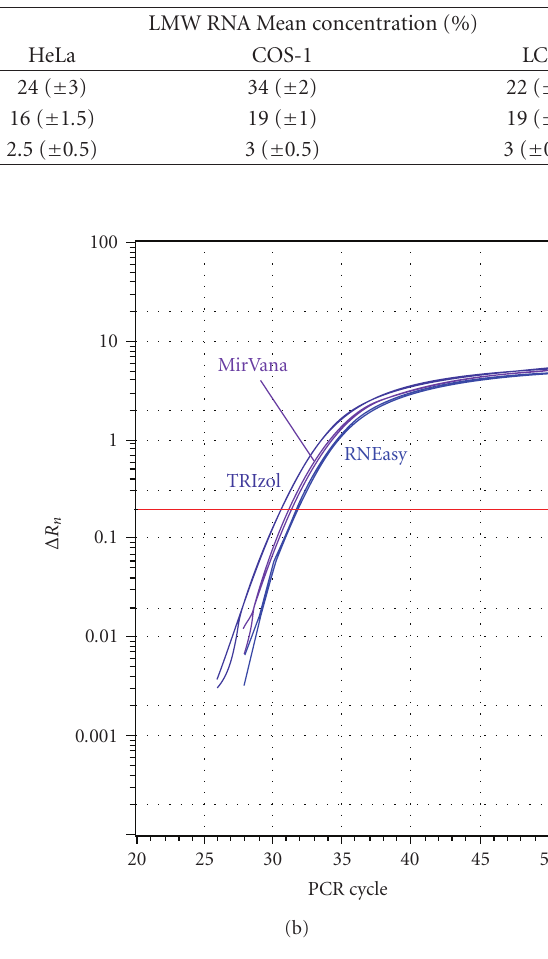
Figure 4: Small nucleolar Z30 real-time PCR assay (two replicas) of RNA samples (LCL) obtained starting from 10ng of total RNA samples (a) and from 10 ng of LMW RNA (b) extracted with di ff erent protocols. In the latter case Ct values of samples from di ff erent extractions are more reproducible, indicating a strict correlation between the amount of miRNAs and the LMW RNA